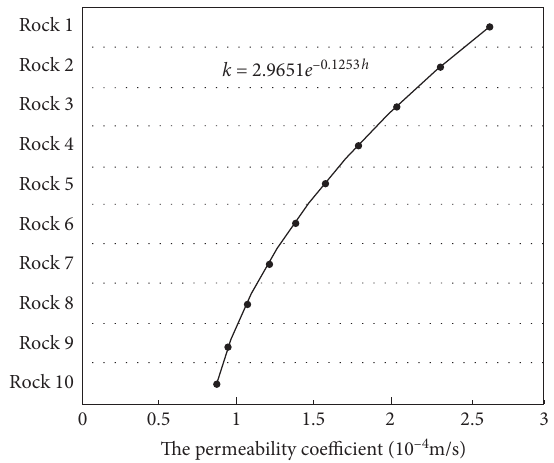
Figure 13: Distribution of permeability coefficient of the F